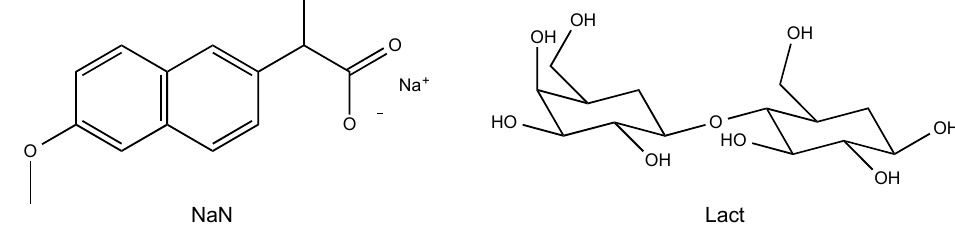
Figure 9. Chemical structures of sodium naproxen (NaN) and lactose (Lact).